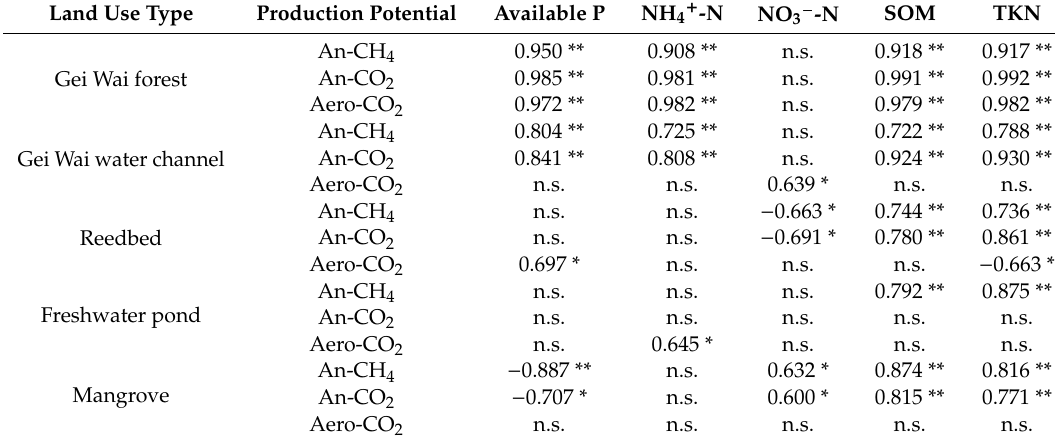
Table 3. Correlation coe ffi cients between gas production potentials and soil properties across all land use types and depths in the top 50 cm soils (n =